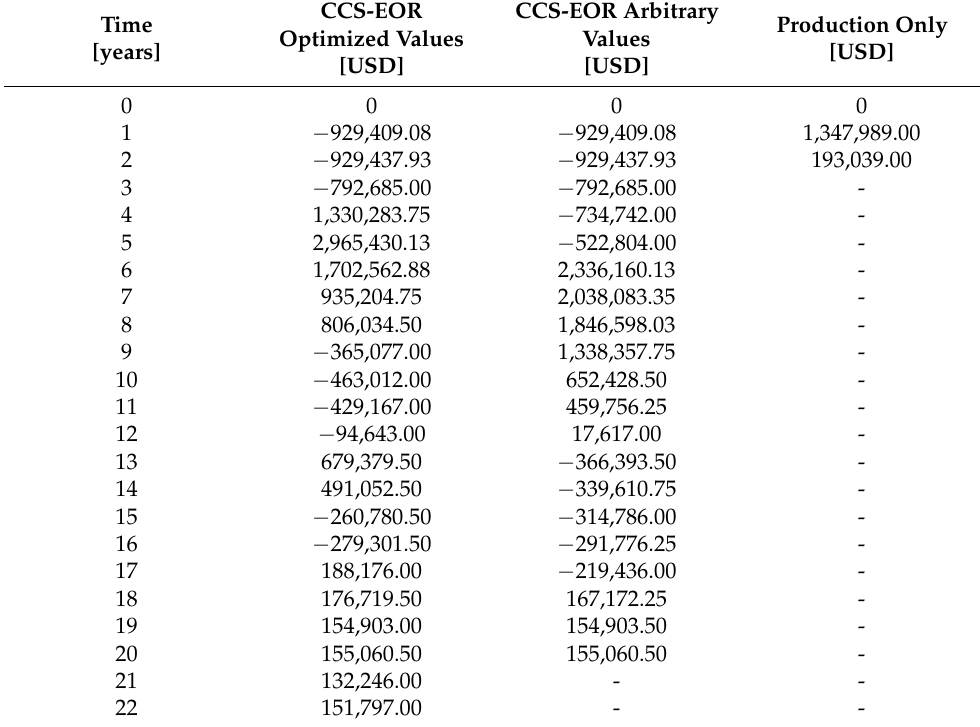
Table 2. Comparison of present